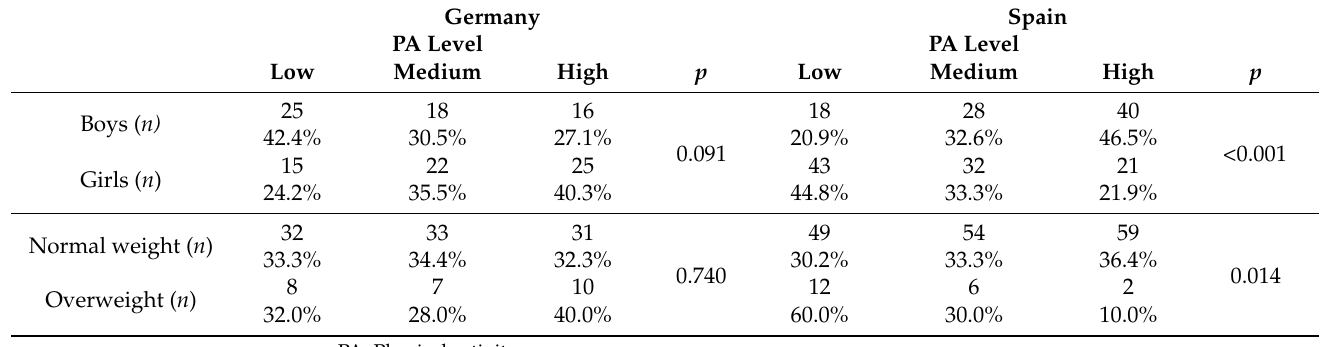
Table 2. PA level distribution for gender and BMI group by country.